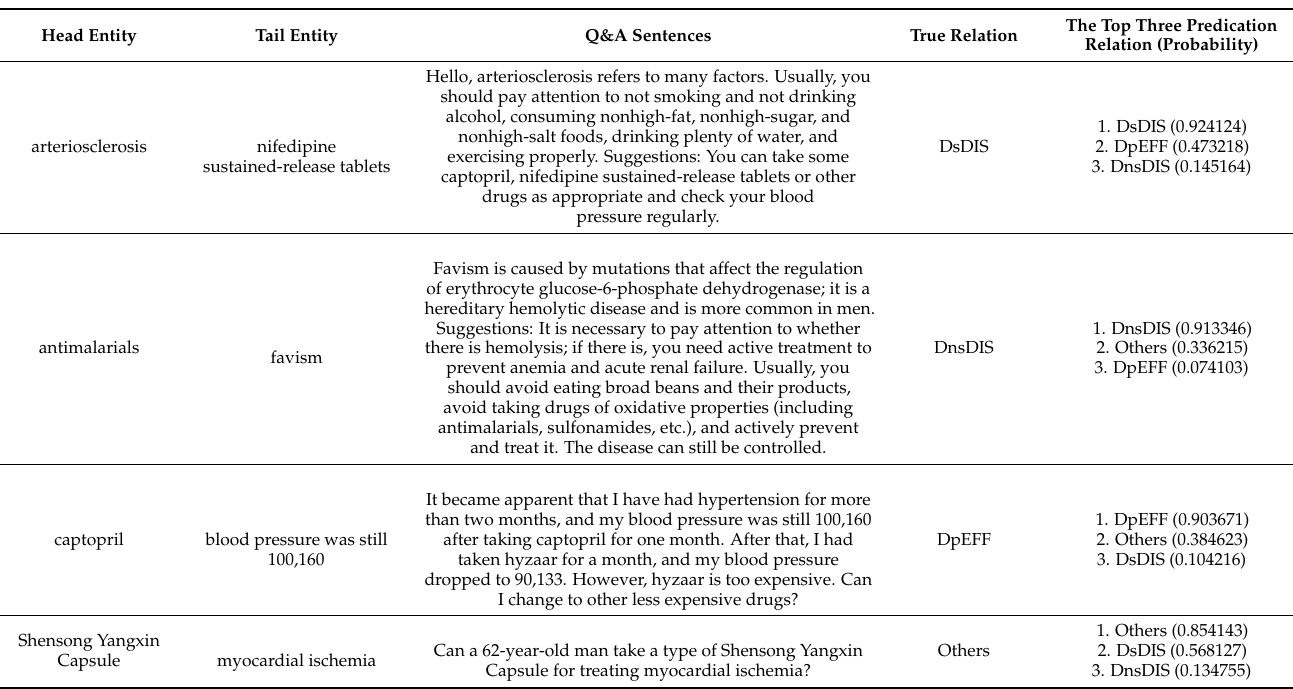
Table 5. Prediction results on the Q&A data relationship extraction task.